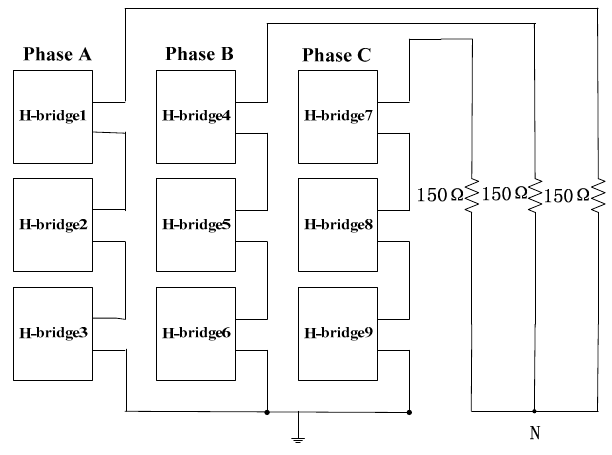
Figure 17. 7-level cascaded multilevel inverter.